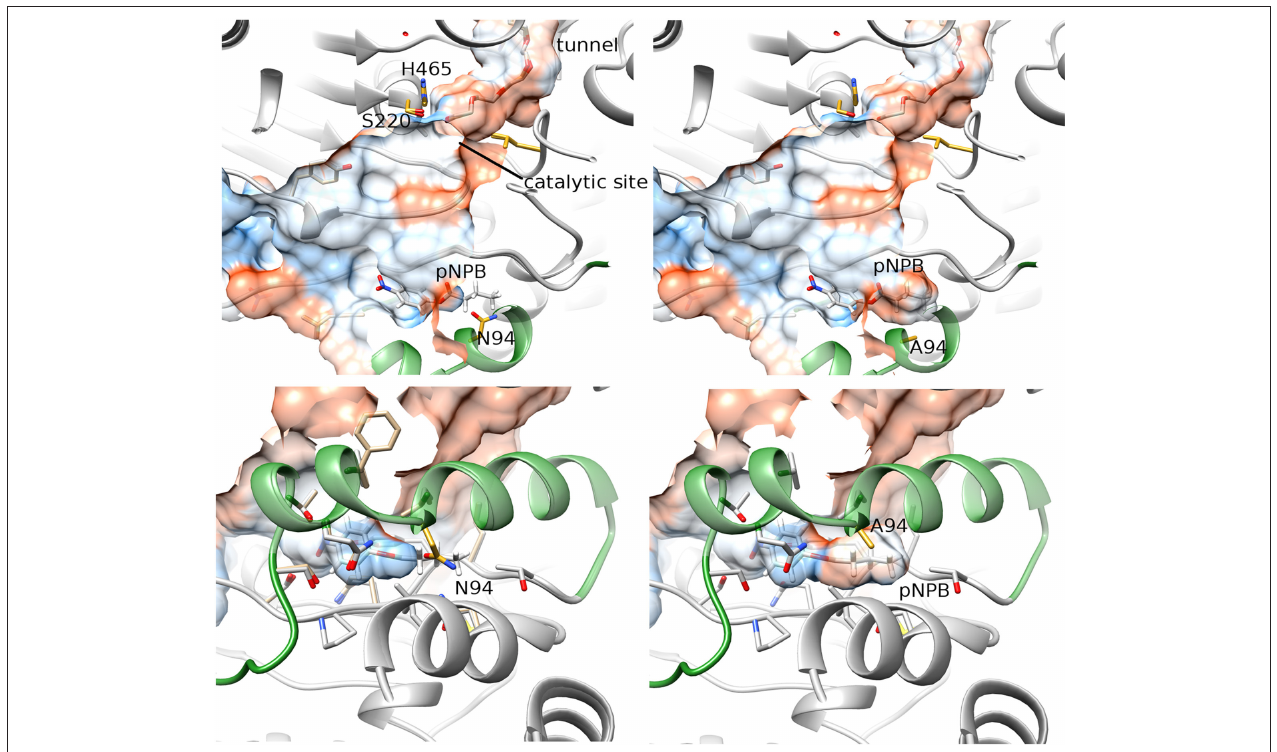
FIGURE 2 | Representation of the docking between pNPB and OPE WT (left) and N94A (right). The lower panels represent a rotated view of the lid area. The hydrophobicity of surfaces is represented from blue for the most hydrophilic, to red for the most hydrophobic regions. The lid is represented in forest green.